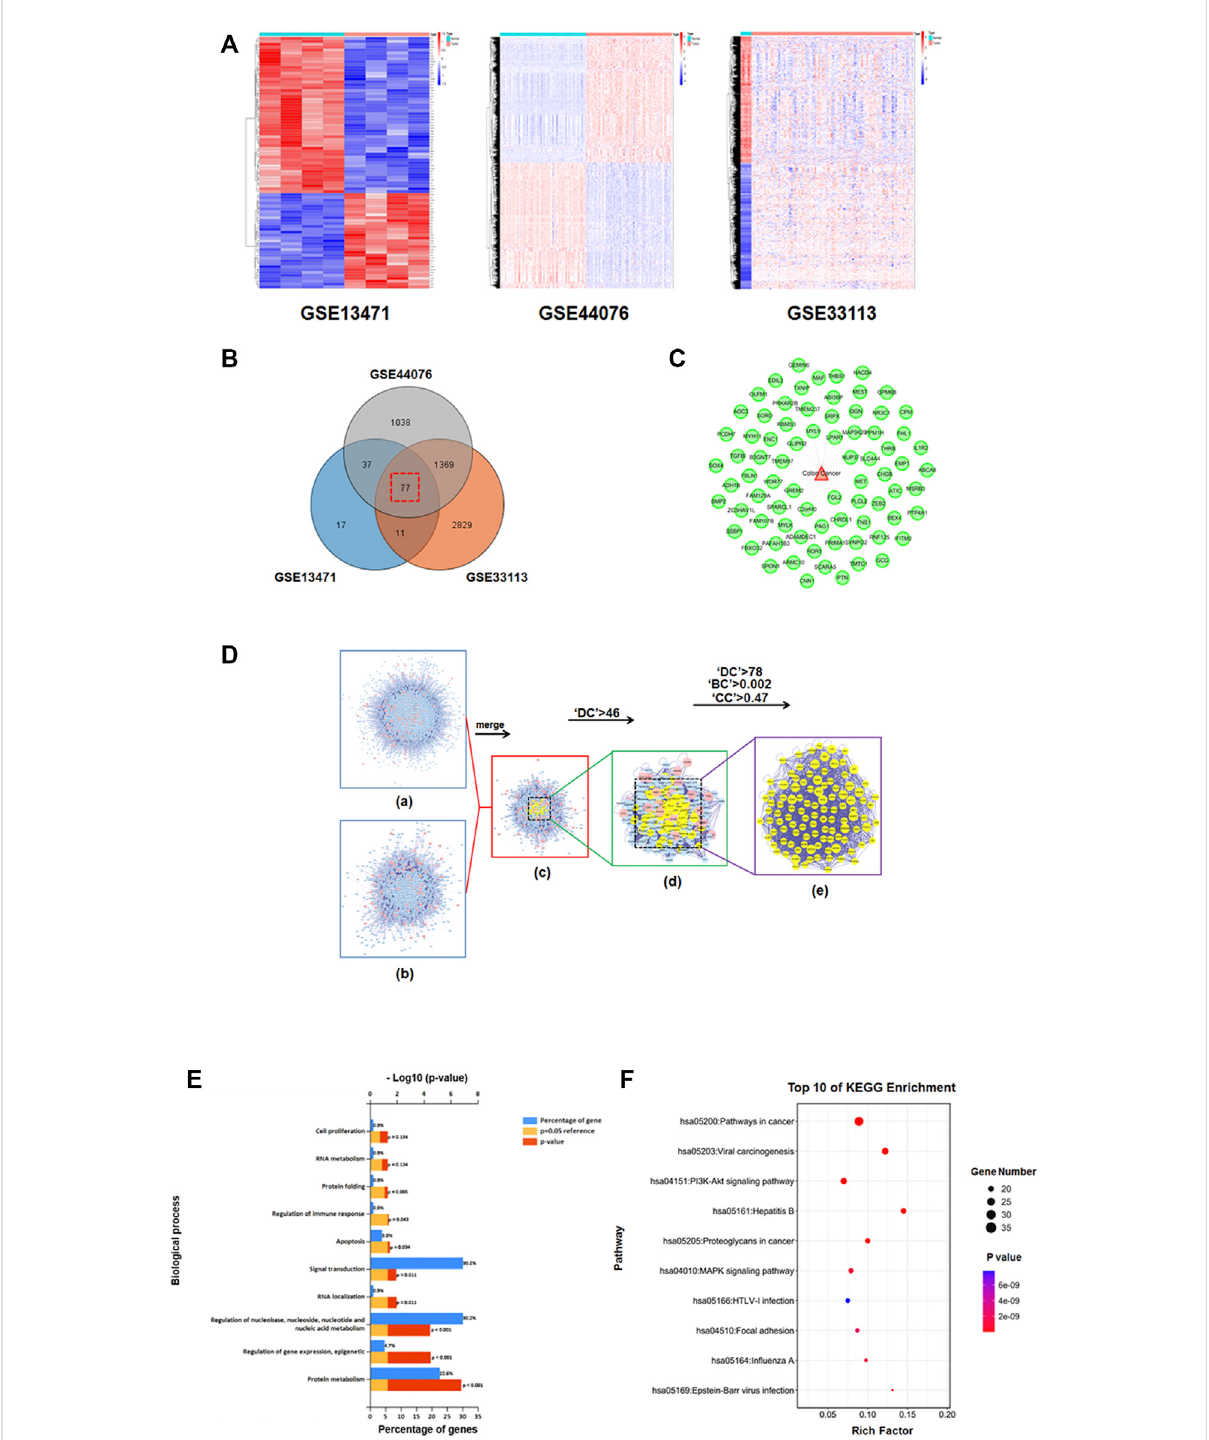
FIGURE 4 Known CC-associated targets were screened from the GEO database, and screeening the candidate core targets for HGWD against CC and enrichment analyses. (A) Three heat maps from GEO chips, including GSE13471, GSE44076 and GSE33113. (B) Venn diagram of 77 common CC- associated targets from three GEO chips. (C) Establishment of the CC-associated targets network. (D) (i) PPI network of HGWD putative targets was composedof6,755nodesand154,869edges.(ii)ThePPInetworkofCC-associatedtargetswasmadeof1,658nodesand26,392edges.(iii)PPI network of HGWD against CC-associated targets was composed of 1,253 nodes and 22,705 edges. (iv) PPI network of key targets from iii. 311 nodes and 8,609 edges are shown. (v) PPI network of candidate core targets from iv. 107 nodes and 2,194 edges are shown. (E) The core targets were enriched in the representative biological processes (GO-BP) by using FUNRICH version 3 ( p < 0.05) (F) The core targets were enriched in the representative signaling pathways (KEGG) by using DAVID v6.8 ( p <